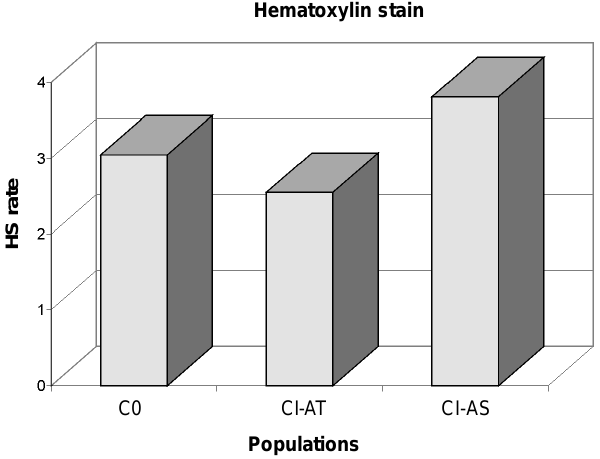
Figure 2 - Mean hematoxylin staining (HS) values of the original (C0), Al- tolerant (CI-AT) and Al-susceptible (CI-AS)